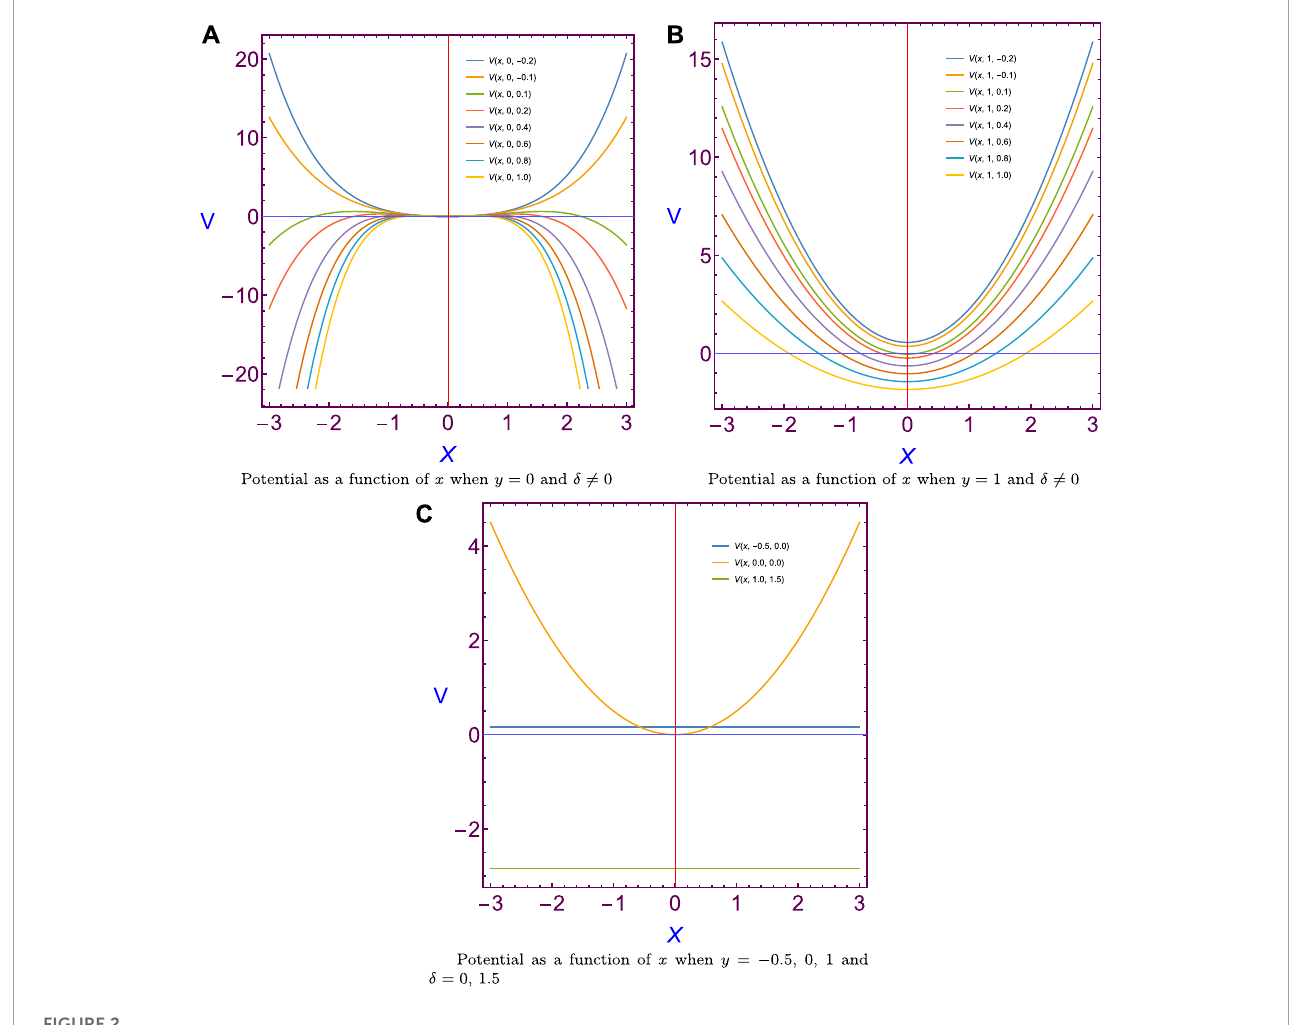
FIGURE 2 Hénon–Heiles potential for different values of transition parameter δ when y is constant.